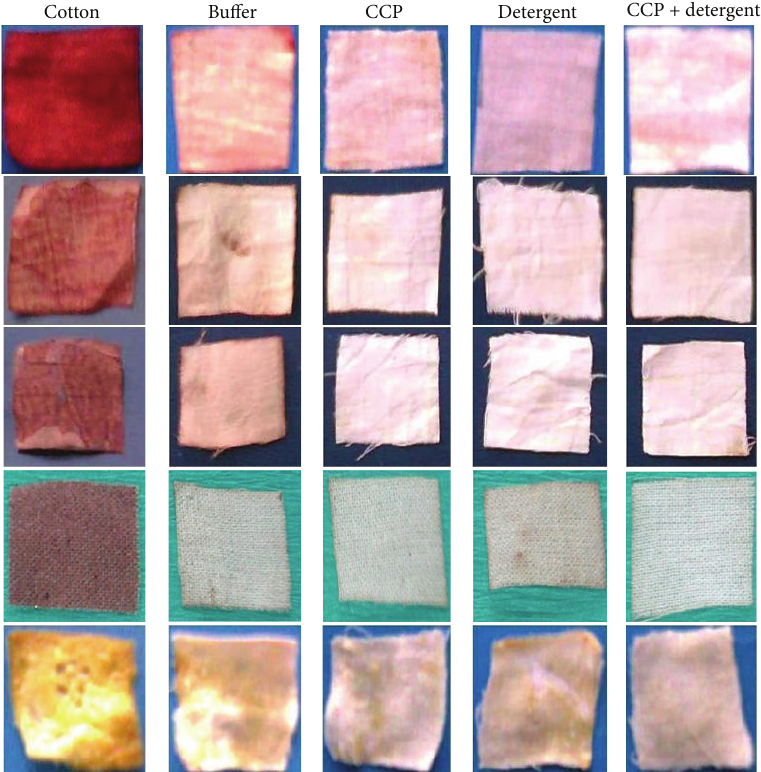
Figure 6: Removing blood and egg yolk stains from cloth by the application of protease (CCP) and detergent after 25min. First column: Untreated blood stained cloth (control); second column: blood stained cloth washed (BSCW) by buffer; third column: BSCW by CCP; fourth column BSCW by detergent; fifth column: BSCW by detergent with CCP. First, second, third, and fourth row: cloth stained by blood sample of human being, ox, buffalo, and hen, respectively. Fifth row: cloth stained by egg